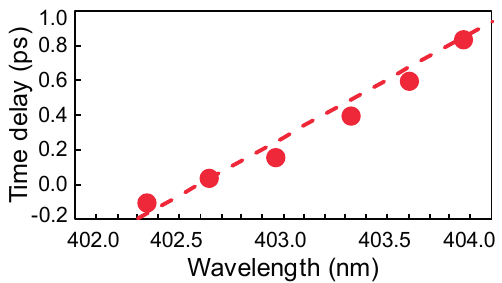
Figure 5. Delay between the spectral components measured in the cross-correlation signal shown in Figure 4c as a function of the wavelength. The dashed line represents the time delay introduced by the intracavity dispersion-compensation